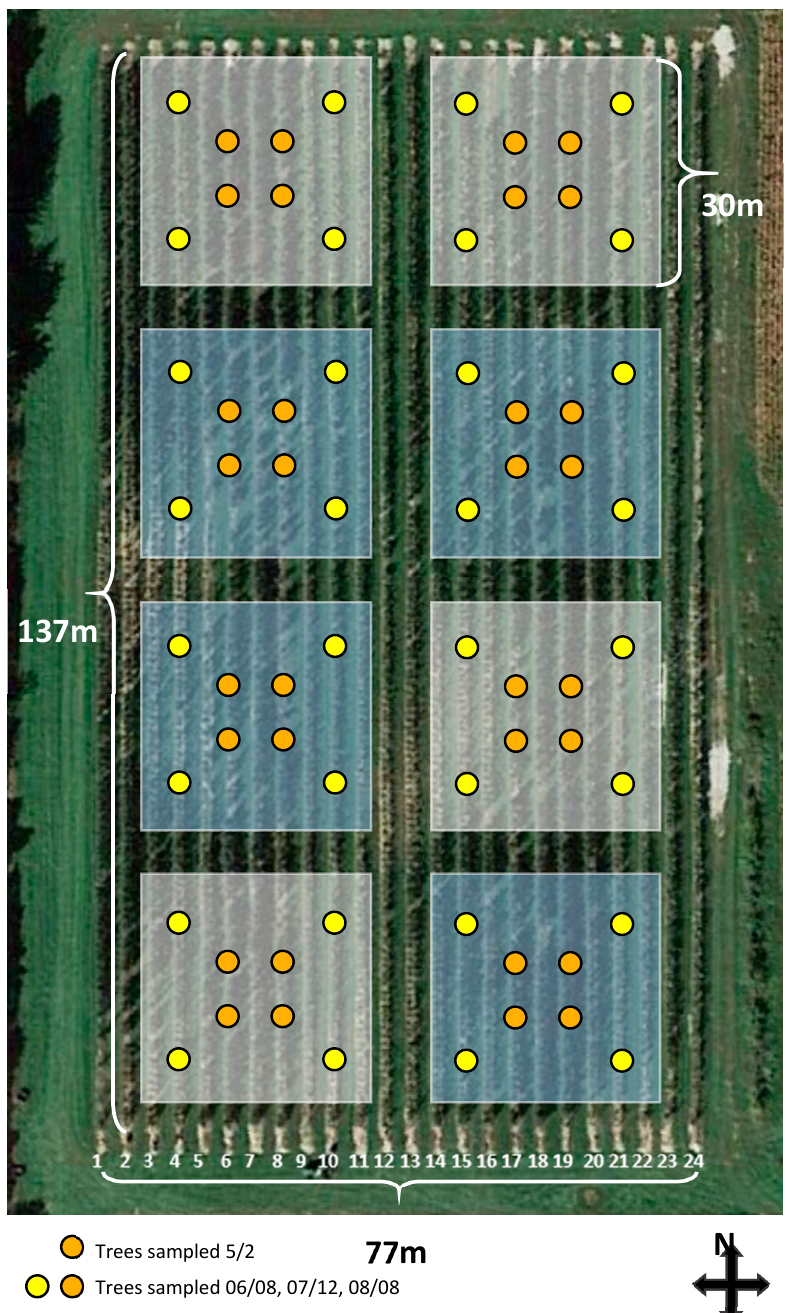
Figure 1. Plot plan of the SSCDS orchard installation. Blue shaded squares denote SSCDS sprayed plots, white squares are airblast plots. Yellow and orange markers are the approximate location of sampled trees.